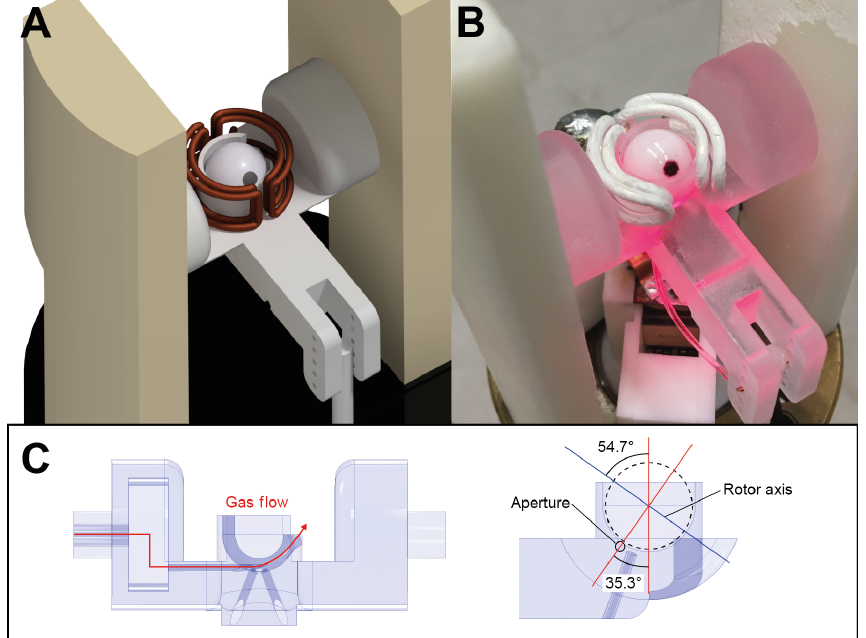
Figure 1. Experimental apparatus. (a) Probehead design schematic depicting the stator with a double-saddle coil, spherical rotor, and angle adjust arm. (b) Fully assembled probehead. (c) Cross-section views of the stator showing the drive gas inlet and angled through holes for the fiber optic tachometer. Drive gas is fed through the nozzle aperture placed at the complement of the magic angle (35.3 ◦ ) into the stator cup.